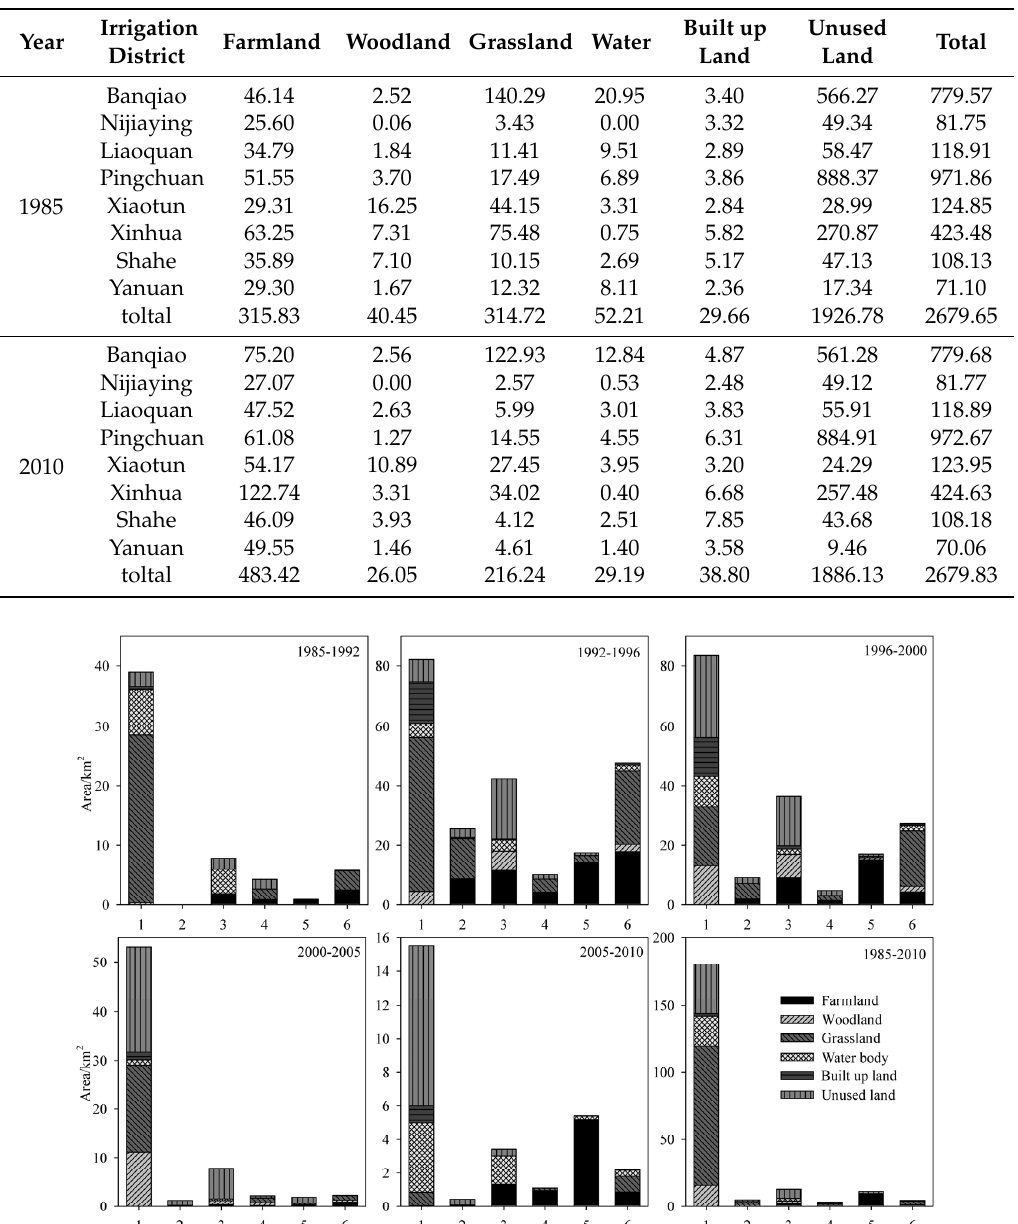
Table 7. Land use/cover of different irrigation districts in 1985 and 2010 (km 2 ).